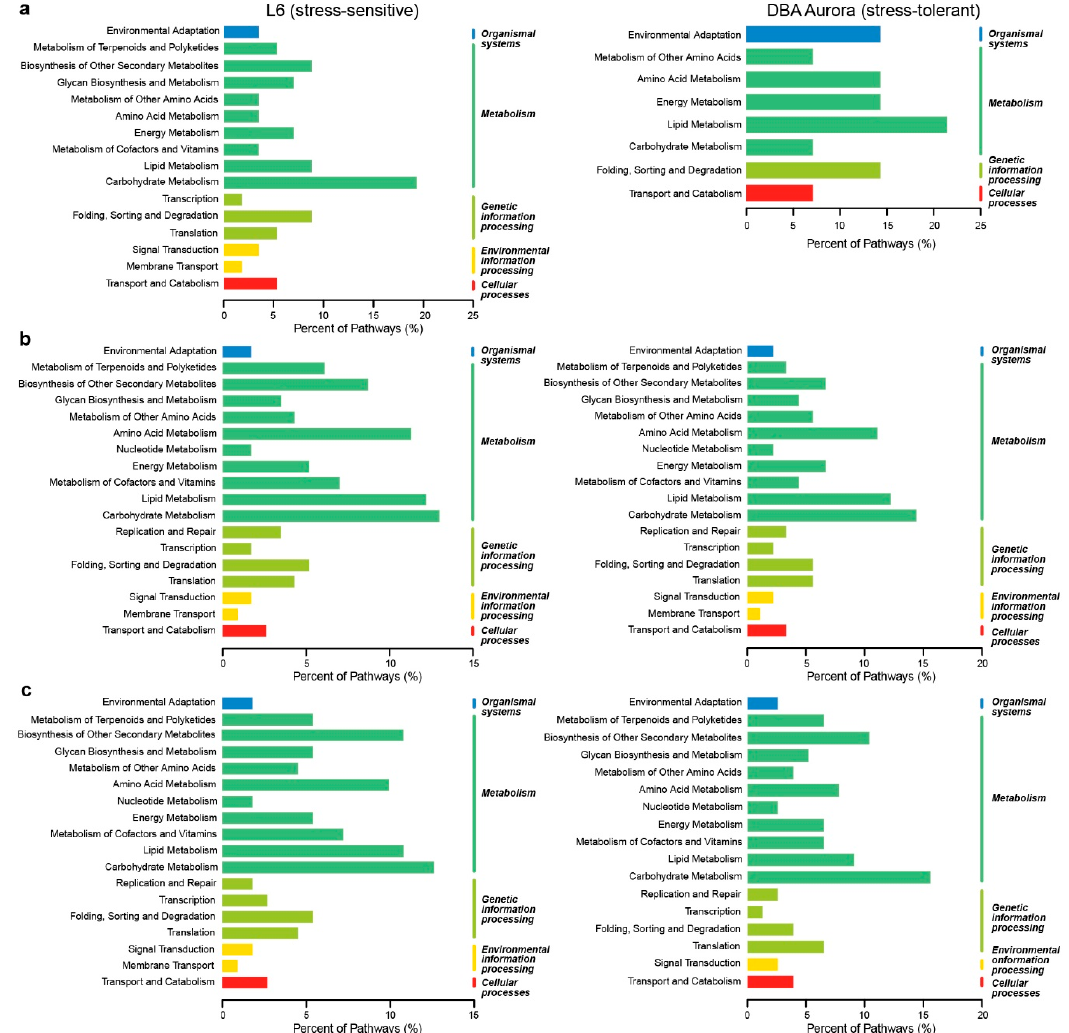
Figure 3. KEGG (Kyoto Encyclopedia of Genes and Genomes) pathway classification of stress-responsive microRNA-mRNA regulatory modules in two durum wheat genotypes. ( a ) In response to water-deficit stress. ( b ) In response to heat stress. ( c ) In response to water-deficit plus heat stress.